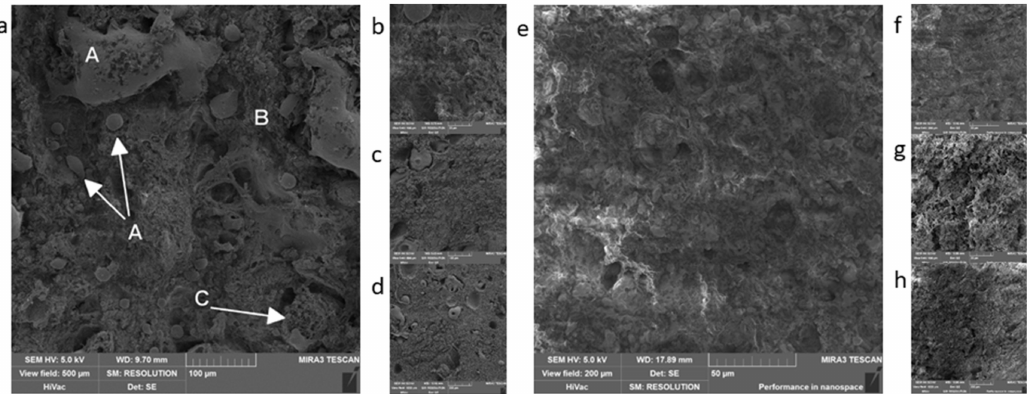
Figure 3. Cans: ( a , b )—J á trovka, procedure 1, A—fat, B—connection (muscle), C—protein net; ( c , d )—Matˇej, procedure 1; ( e , f )—J á trovka, procedure 2; ( g , h )—Matˇej, procedure